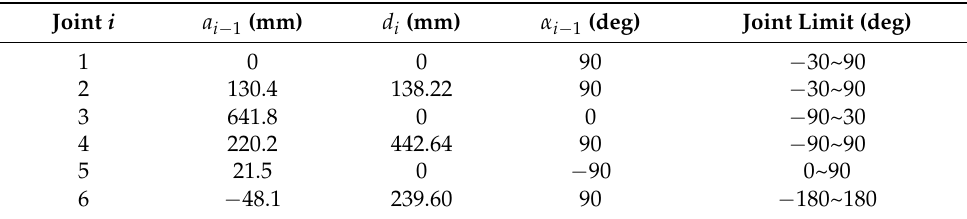
Table 1. D-H parameters for the deep-sea electric manipulator. Joint